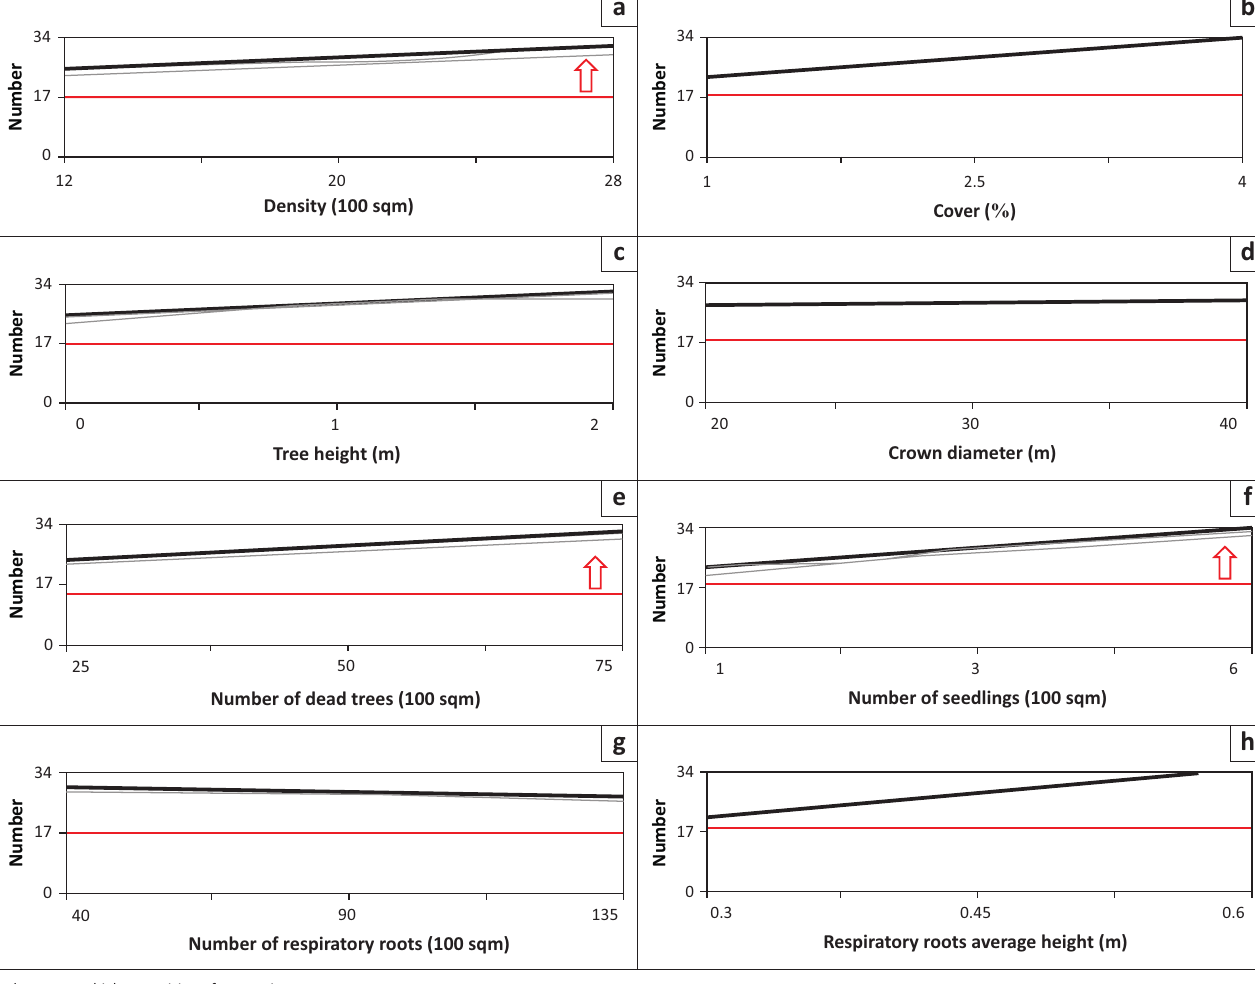
FIGURE 4: Usfan demographic features sensitivity analysis. (a) Density (100 m 2 ); (b) Cover ( % ); (c) Tree height (m); (d) Crown diameter (m); (e) Number of dead trees (100 m 2 ); (f) Number of seedlings (100 m 2 ); (g) Number of respiratory roots (100 m 2 ) and (h) Average height of respiratory roots (m).